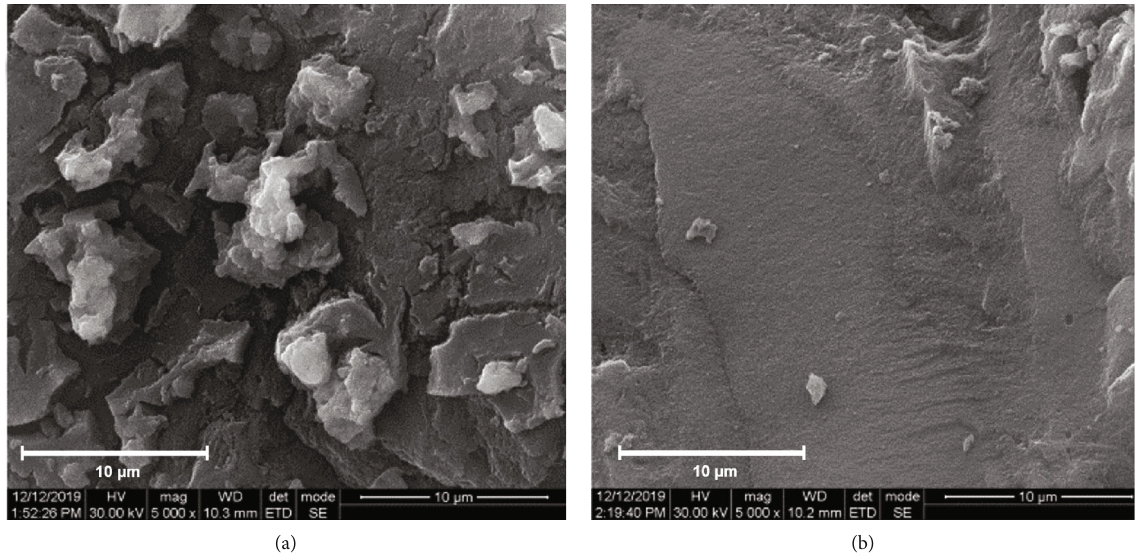
Figure 17: SEM morphology of biochar (a) JPAC and (b) JPAC/TiO